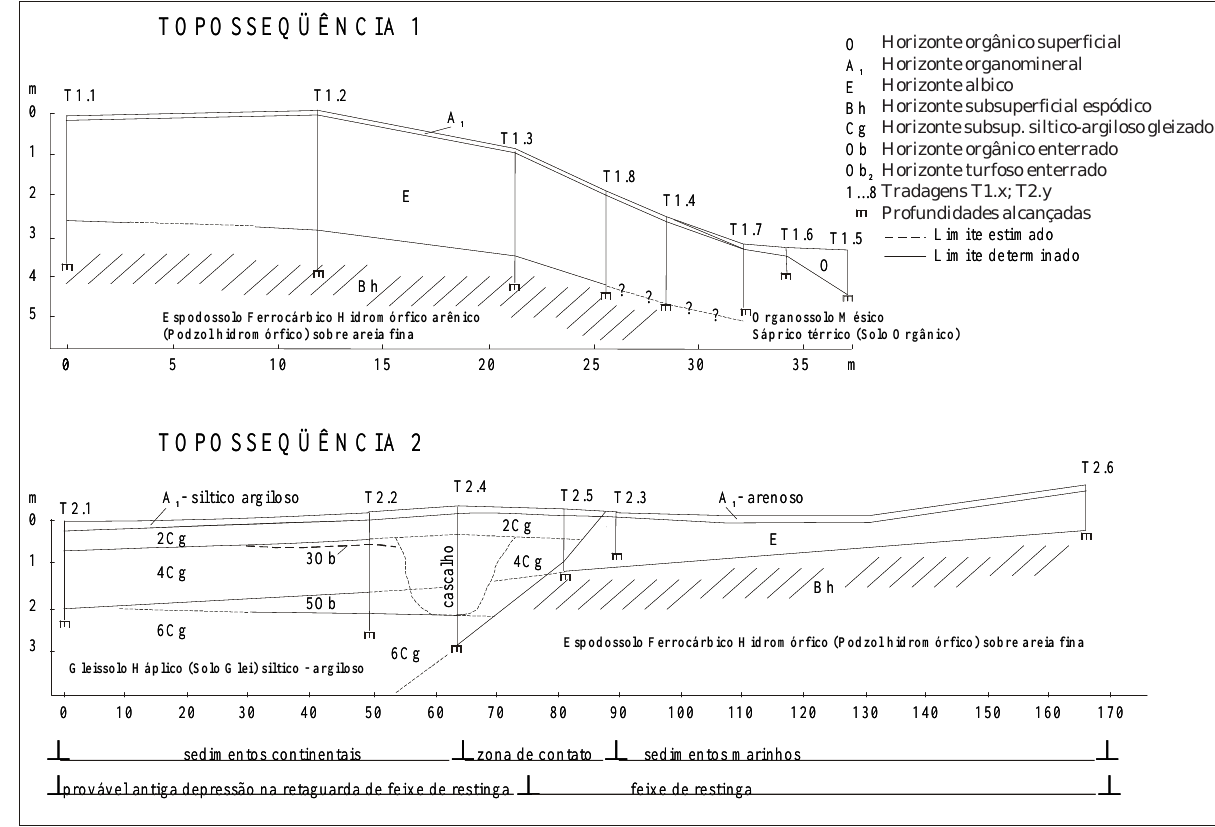
Figura 2. Toposseqüências 1 e 2 representando a passagem de Gleissolo (solo glei) para Organossolo (solo orgânico) e Gleissolo (solo glei) para espodossolo (Podzol),